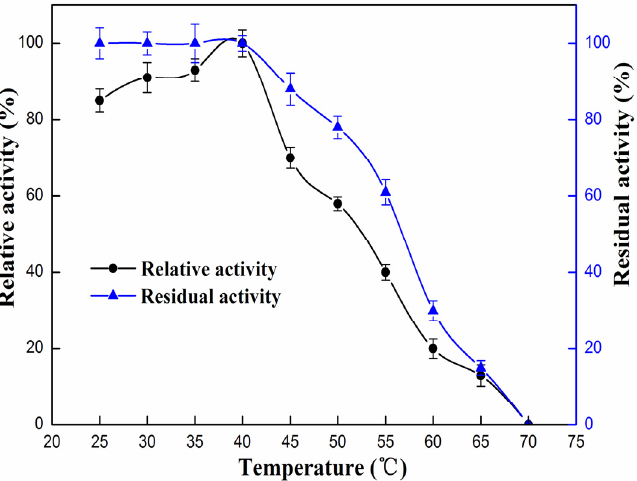
Figure 4. Influence of temperature on rProROL activity and stability. The lipase activity was measured with a pH-stat (Metrohm) and using olive oil as substrate. The optimum temperature of purified rProROL was measured at different temperatures ranging from 25 to 70 °C. The relative activity at different temperatures was calculated by setting 40 °C as 100%. The thermal stability was studied by incubating lipase at various temperatures (25–70 °C) in Tris-HCl buffer (pH 8.0) up to 1 h. The residual enzyme activity was measured at 40 °C with olive oil as substrate and the residual activity was calculated by taking the non-heated lipase activity as 100%. All measurements were carried out in